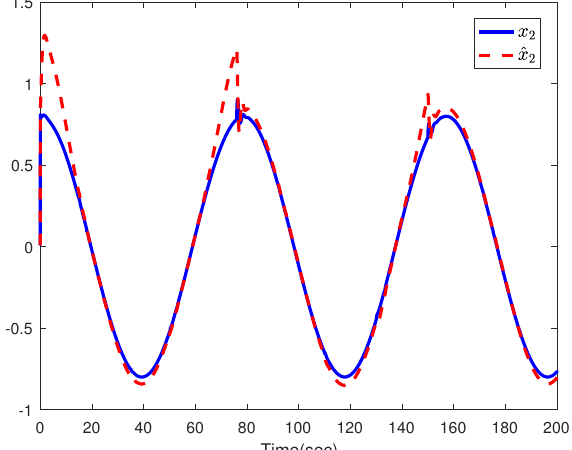
Figure 3. Responses of states x 2 and ˆ x 2 .